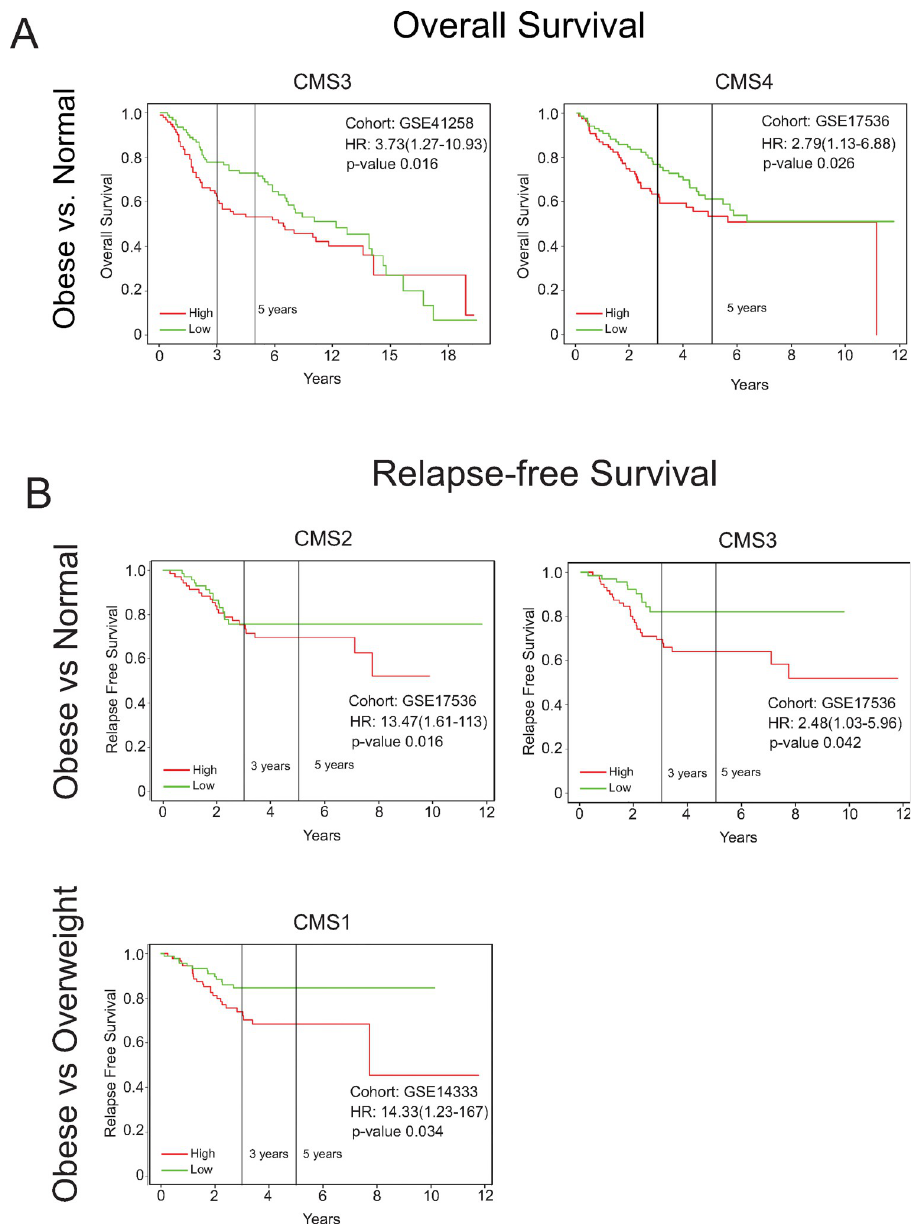
Fig 3. Prognostic patient outcomes reveal CMS-specific differences between obese BMI groups. The expression of the top 20 significantly upregulated DESeq2-obtained DEGs (MeanBase > 10, FDR p value < 0.05) in the obese vs. normal and obese vs. overweight comparisons for each CMS category were assessed in GSE17536 and GSE41258 for overall survival (A) and GSE14333 and GSE17536 for relapse-free survival (B) using the PROGgeneV2 tool. Survival analyses were adjusted for age, stage, and gender covariates and bifurcated based on median expression. The hazard ratios, 95% confidence intervals, and p values were reported for the Kaplan-Meier